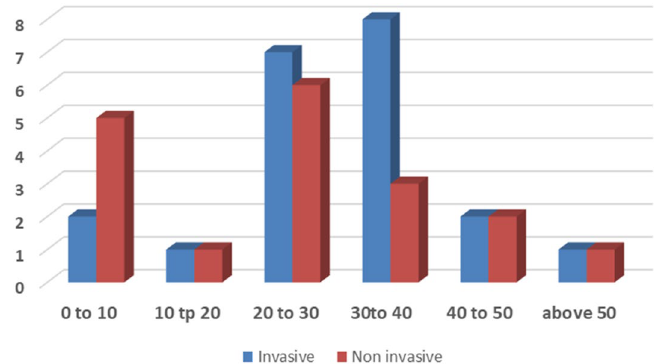
Figure 2. Age distribution among patients.